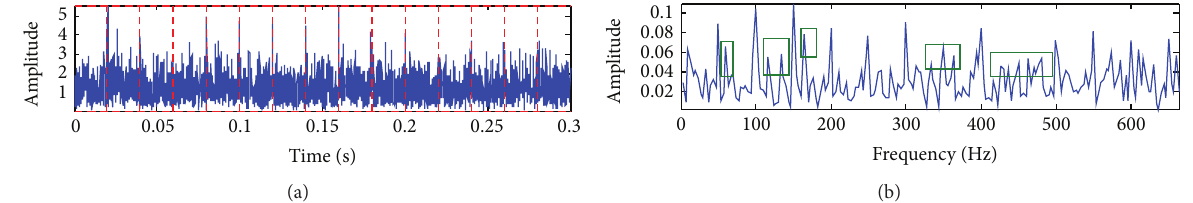
Figure9:AnalyzedresultsofsimulatedsignalwithdoubleresonancebandshowninFigure 8(b)byHilberttransform:(a)envelopewaveform; (b) envelope spectrum.